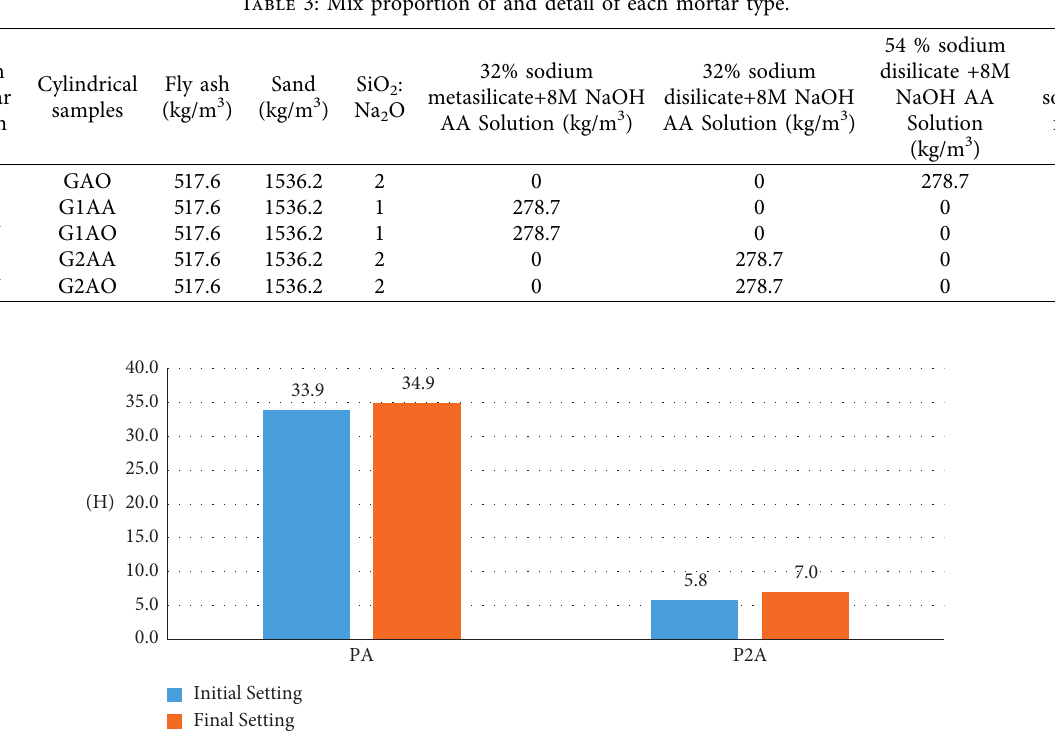
Table 3: Mix proportion of and detail of each mortar type.